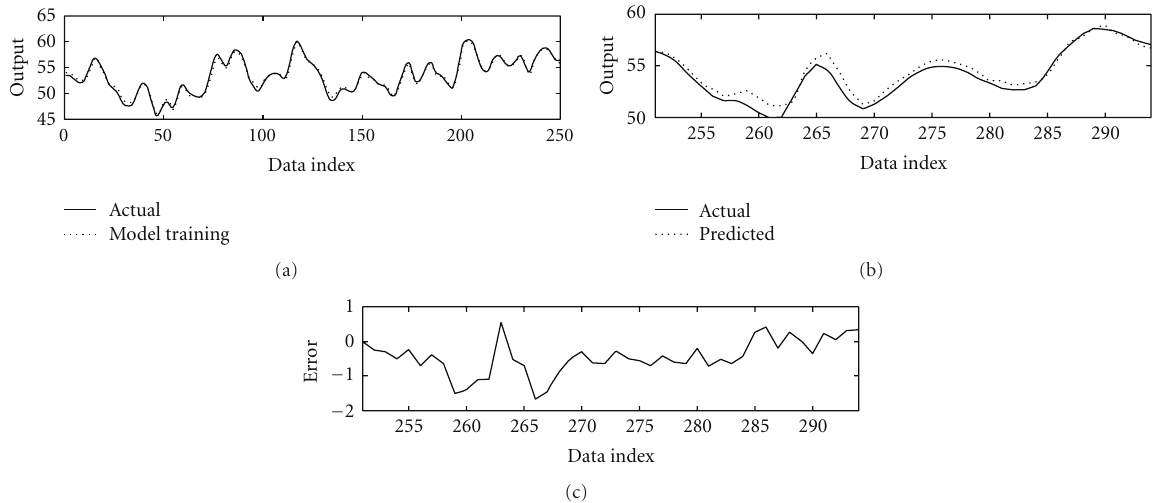
Figure 1: Plot of actual output and model output for training data set (uppermost plot) and plot of actual output and predicted output and the corresponding prediction error for Box and Jenkins’s gas furnace data.